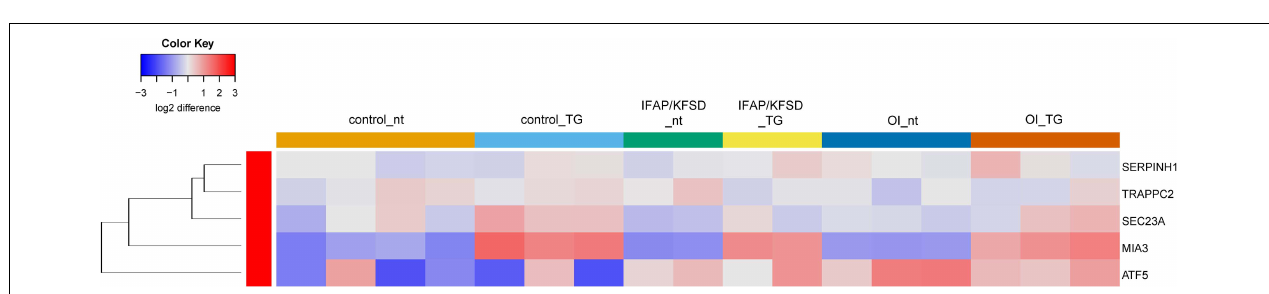
FIGURE 5 | Heatmap depicting expression levels of genes that are transcriptionally regulated by OASIS at basal conditions (nt: no treatment) and in the presence of thapsigargin (TG). The dendrogram on the left y-axis shows clustering of the genes.